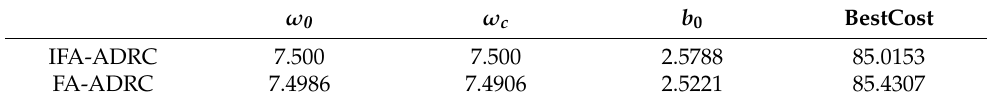
Table 4. Optimization parameters under LADRC and error integration index.